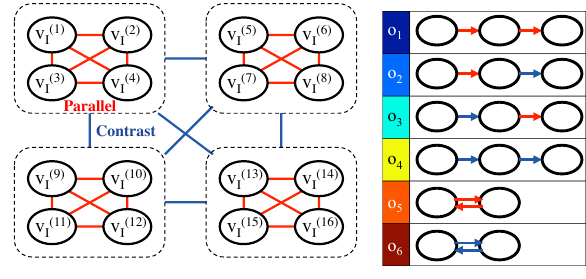
Figure 13 . Encoding of eye movements. (a) Edges between dotted frames indicate that every node in the frame is con- nected to every node in the other frame. (b) Six patterns of tri-gram paths in the graph G D . The two bottom features cor- respond to comparison patterns in which the first and the last dwell of the tri-gram is on the same